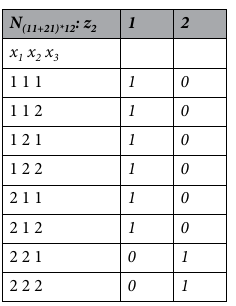
Table 3. Boolean Matrix of N (11 + 21)*12 .